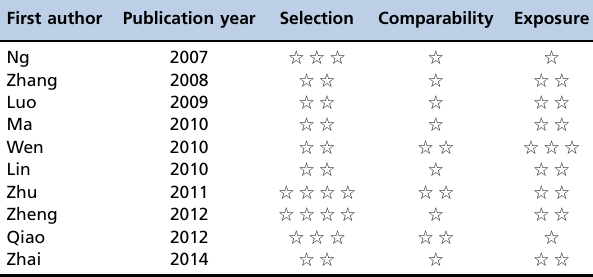
Table 2 - Quality assessment of all of the included